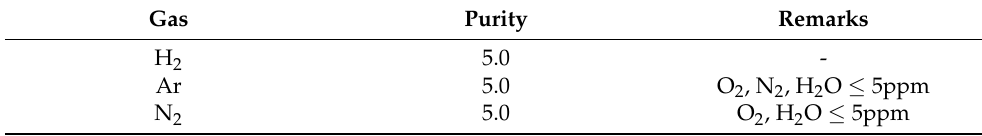
Table 6. Qualities of the gases used for the